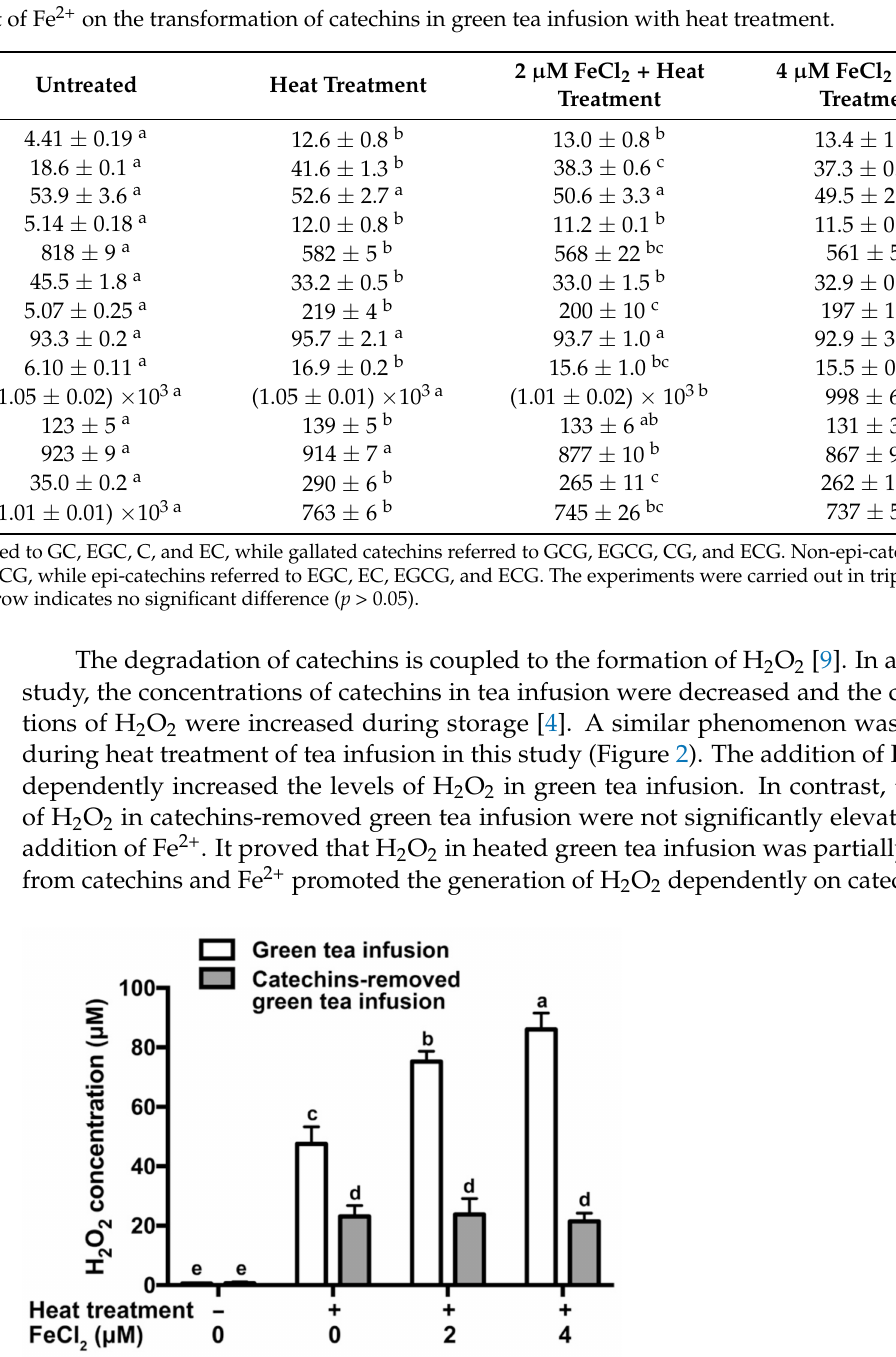
Figure 2. Effect of Fe 2+ on the accumulation of H 2 O 2 in green tea infusion with heat treatment. The same letter within each column indicates no significant difference ( p >